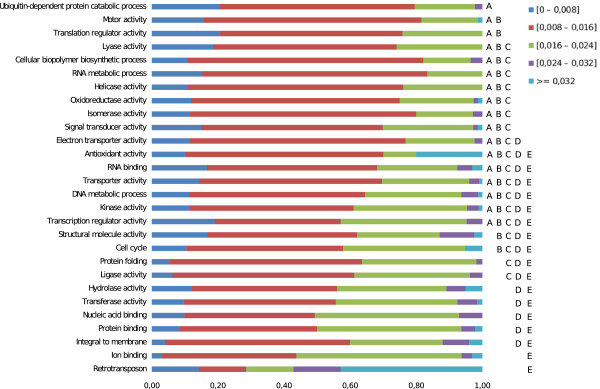
Genetic diversity in functional classes (Gene Ontology). Alignments containing genes annotated with GO terms (2,158 alignments) were grouped into higher-level classes based on the GO ontology of terms using GOSlim, and also based on nucleotide diversity ([0–0.008); [0.008–0.016); [0.016–0.024); [0.024–0.032); >= 0.032). Differences between categories were observed and are marked in the figure (Kruskal-Wallis test, P < 0.0001; a posteriori test, P < 0.05). Different letters indicate significant differences.